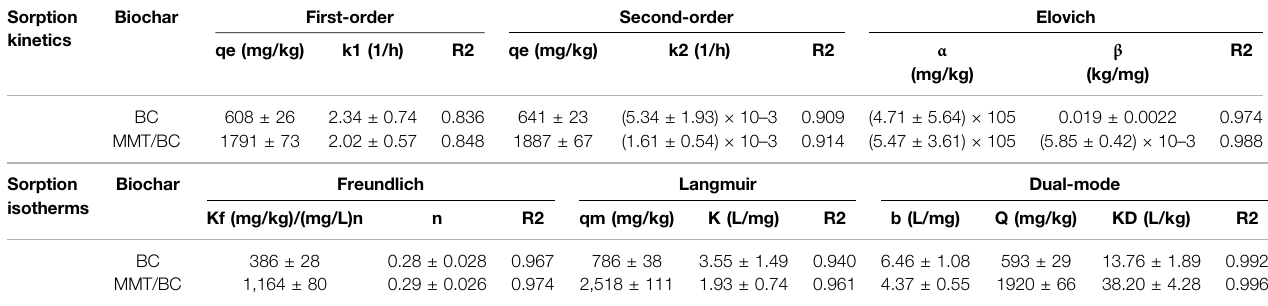
TABLE 2 | Fitting parameters of sorption kinetics and sorption isotherms of atrazine on BC and MMT/BC. Sorption Biochar First-order kinetics